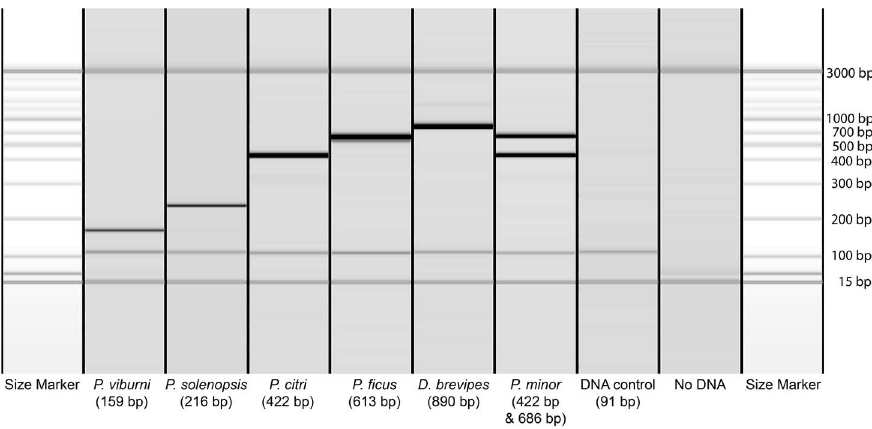
Figure 3. Electrophoresis profile obtained with the Qiaxcel Advanced System for each PCR product from the identification kit. Each lane corresponds to one sample, and each band to a DNA fragment. The first and last lanes contain a molecular weight ladder extending from 50 bp to 2.5 kb size marker. The bands at 15 bp and 3 kb correspond to the Alignment marker used by the Qiaxcel Advanced System to align the lanes.